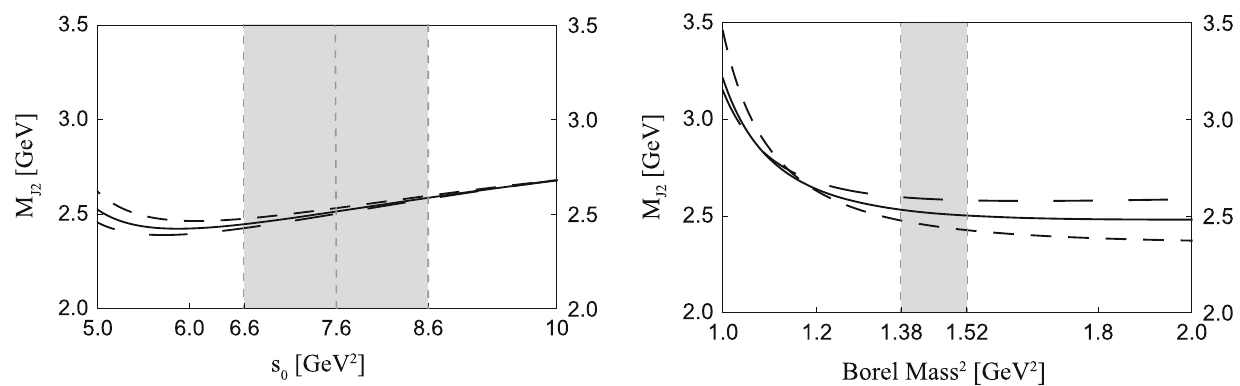
= 1 . 38 / 1 . 45 / 1 . 52 GeV 2 , respectively. In the right panel the ting M 2 B short-dashed/solid/long-dashed/dotted curves are obtained by setting s 0 = 6 . 6 / 7 . 6 / 8 . 6 GeV 2 ,